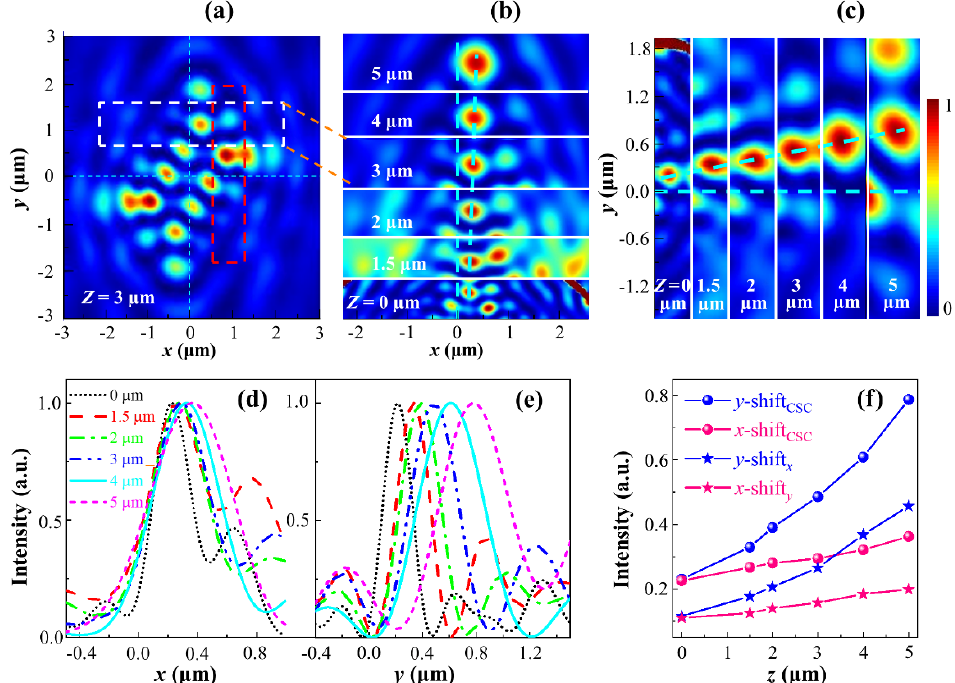
Figure 5. ( a ) Intensity maps of the converted spin component (CSC) light field of z = 3 µm with RCP illumination, ( b – c ) Intensity stripes including the characteristic spots with x -shift ( b ) and y -shift ( c ) as the stripes in the white and red dotted boxes in ( a ), respectively, which are intercepted from different intensity maps of z = 0–5 µm, ( d – e ) Normalized cross-sectional intensity profiles of the characteristic spots in ( b – c ), respectively. The distributions in all curves are normalized to their maximum values. Different colors refer to different propagation distances z . ( f ) x -shifts and y -shifts of the characteristic spots in CSC fields ( b – c ), and corresponding spots in x - and y -component fields, respectively.